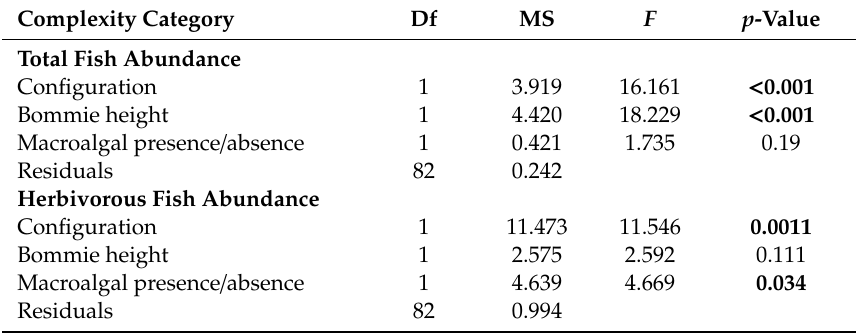
Figure 3. Mean fish density in di ff erent trophic groups extracted from the underwater visual census (point count surveys) surveys in the di ff erent broad- (dense and sparse configuration of bommies) and fine- scale (tall or short bommie height, macroalgae presence or absence) complexity habitats. Sample sizes are presented in parentheses (n). Letters above bar graphs that di ff er denote significant di ff erences among habitat categories. Table 1. Summary statistics from ANOVA models of the e ff ects of seascape configuration (dense versus sparse bommies), bommie height (short or tall), and the presence / absence of macroalgae on the abundances of all fish and on herbivorous fish. Numbers in bold denote significant p -values ( p <